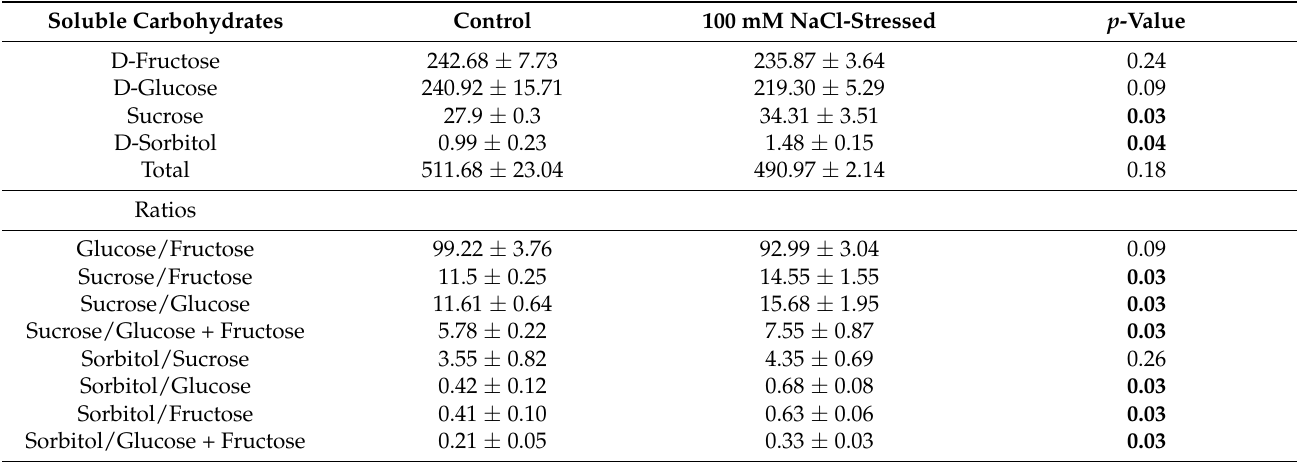
Table 1. Concentrations of D-fructose, D-glucose, sucrose and D-sorbitol and their ratios in F. carica cv. Dottato fruits from control and 100 mM NaCl-stressed plants for 48 days. Values are means ± SD of three replicate fruits expressed as mg g − 1 of fruit dry pulp. p ≤ 0.05 is in bold font. The ratio values are expressed as 100 times the real